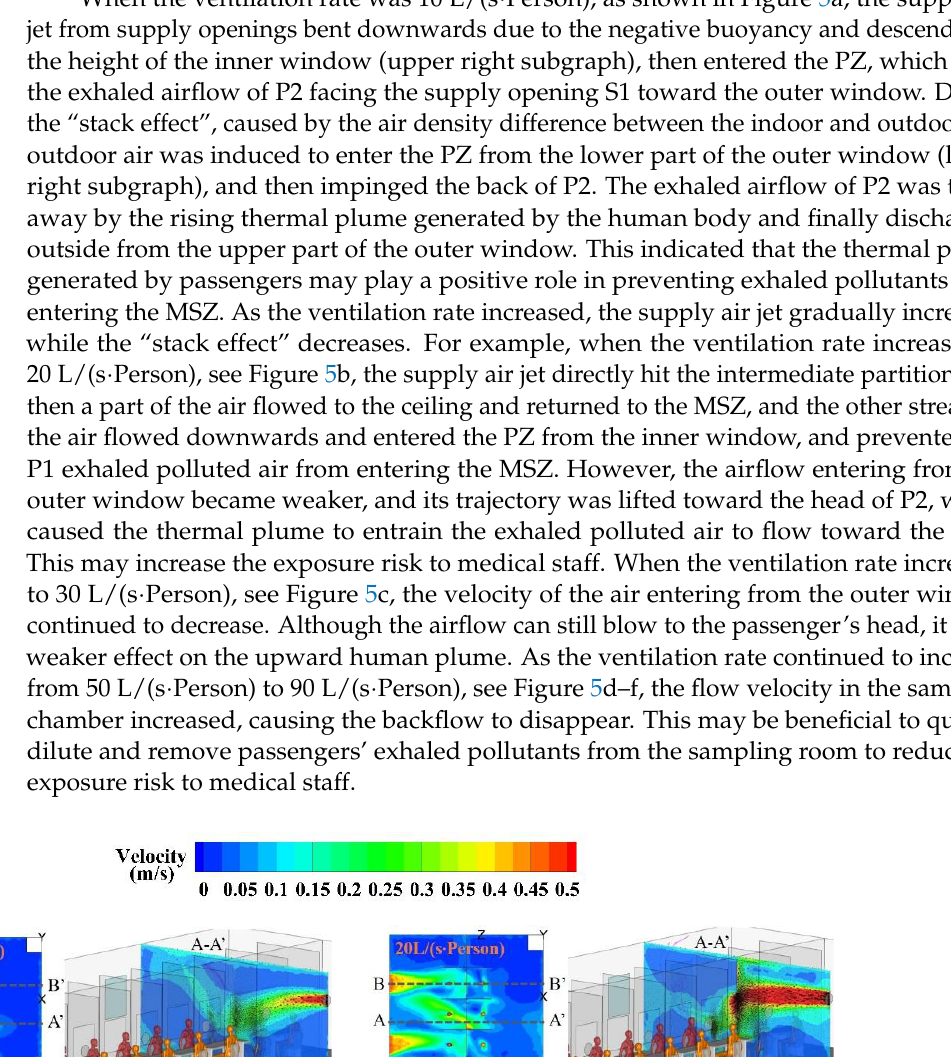
Figure 5. Airflow patterns at the planes of y = 1.1 m, x = 1.09 m, and x = 2.25 m under the MSFV with different ventilation rates: ( a ) 10 L/(s∙Person); ( b ) 20 L/(s∙Person); ( c ) 30 L/(s∙Person); ( d ) 50 L/(s∙Person); ( e ) 70 L/(s∙Person); ( f ) 90 L/(s∙Person). Figure 6 shows the airflow patterns in the sampling cabin at different ventilation flow rates under MEFV. Comparing MSFV and MEFV, the former had a higher jet velocity at